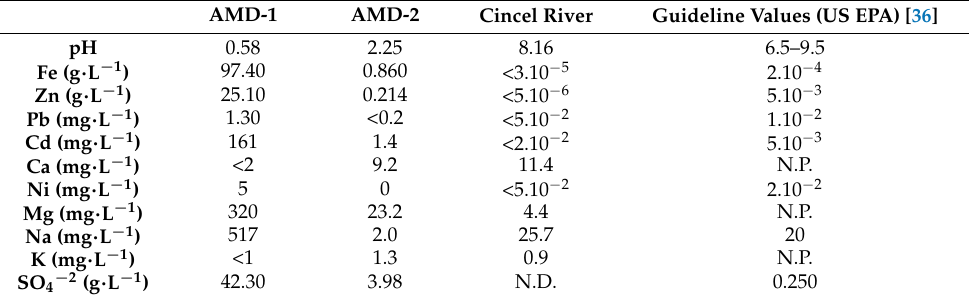
Table 1. Composition of acid mine drainages (N.D.: not determined; N.P.: not